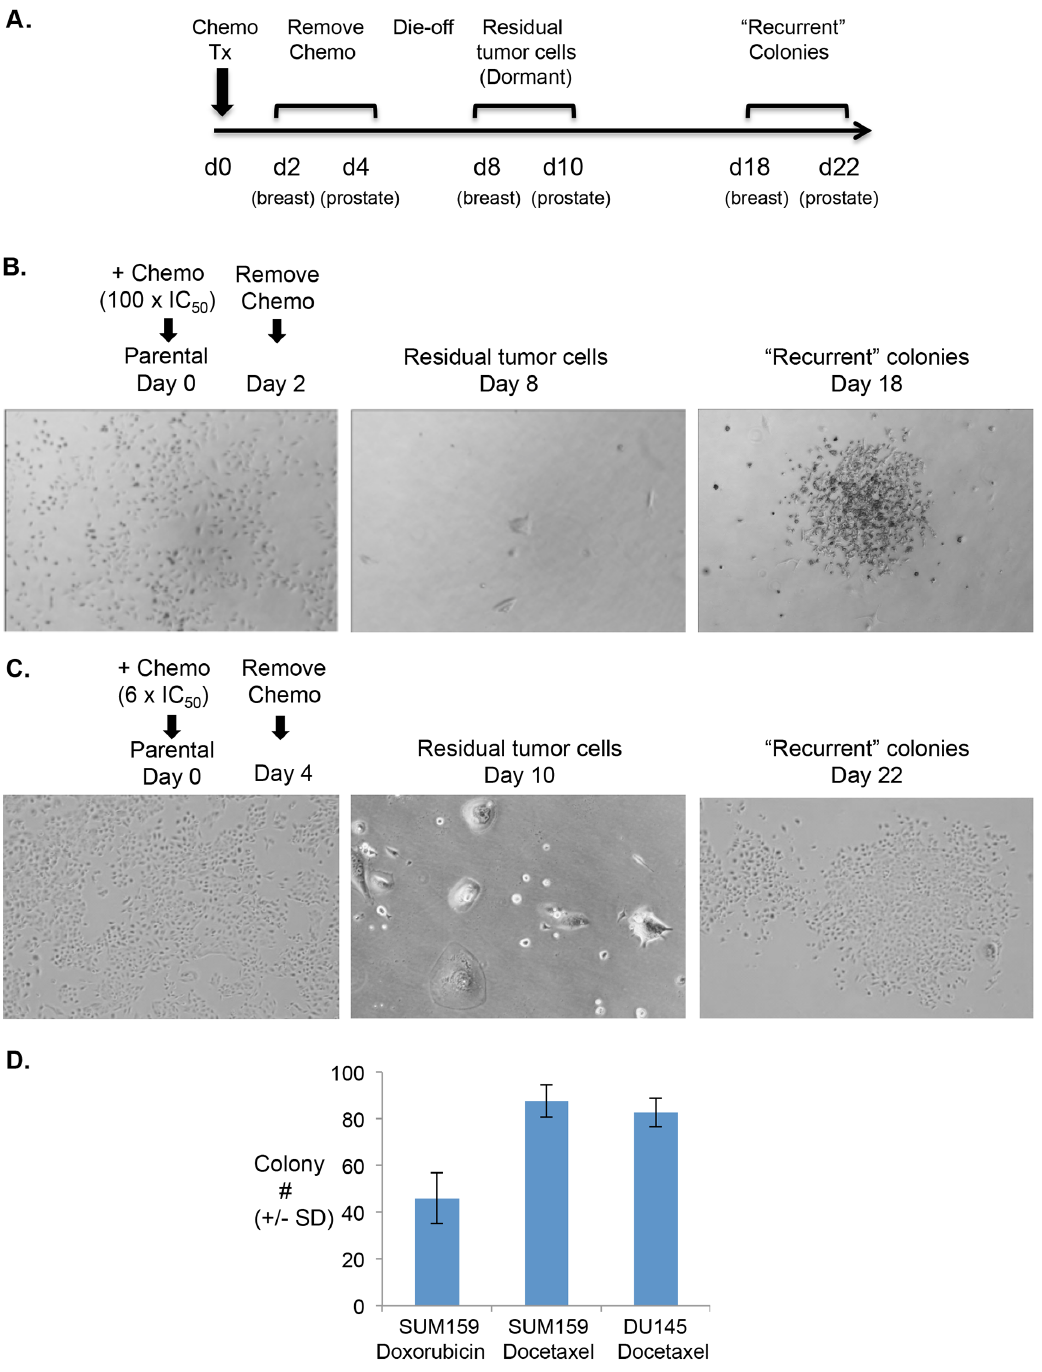
Figure 1. Invitro model of tumor dormancy/recurrence after short-term chemotherapy treatment. A. Schematic of experimental tumor dormancy/recurrence model. Breast (SUM159) or prostate (DU145) tumor cells were treated short term (breast 2 d; prostate 4 d) with chemotherapy in vitro . After 8 d (breast) or 10 d (prostate), dormant tumor cells (breast d8; prostate d10) were observed. Over time (breast d18; prostate d22), these dormant tumor cells resumed growth, establishing ‘‘recurrent’’ colonies. B. SUM159 breast tumor cells (Parental, left panel; 4X) were incubated with Docetaxel (100 nM; 100 fold IC 50 ) for 2 d, after which chemotherapy was removed and fresh culture medium added. Residual tumor cells were imaged on d8 after treatment (Residual tumor cells, middle panel; 4X). Colonies evolving from residual tumor cells were imaged on d18 (‘‘Recurrent’’ colonies, right panel; 4X). Similar results were obtained using SUM159 cells incubated with Doxorubicin (Dox) for 2 d (1 m g/ml; 100 fold IC 50 ; data not shown). C. DU145 prostate cancer cells (Parental, left panel; 4X) were incubated with Docetaxel (10 nM) for 4 d, after which chemotherapy was removed and fresh culture medium added. Residual tumor cells were imaged on d10 after treatment (Residual tumor cells, middle panel; 10X). Colonies were imaged on d22 (‘‘Recurrent’’ colonies, right panel; 4X). D. SUM159 were incubated with Doxorubicin or Docetaxel as in ‘‘B’’. Recurrent colonies were counted using crystal violet on d18. Likewise, DU145 cells were incubated with Docetaxel as in C. Recurrent colonies were counted using crystal violet on d22. Results are representative of at least three independent trials.